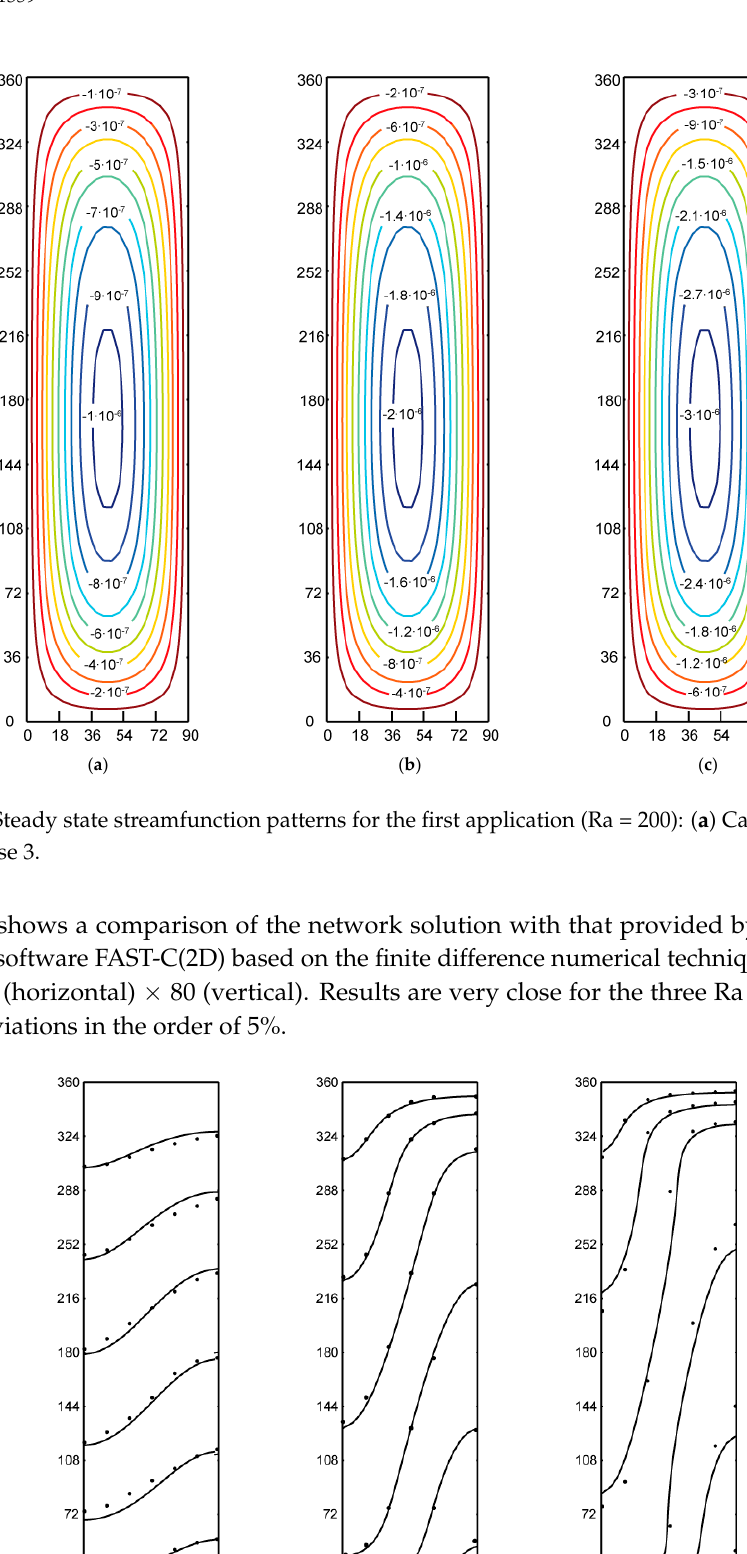
Figure 5. Comparison between network method and finite-difference technique: ( a ) Ra = 200; ( b ) Ra = 300; and ( c ) Ra =